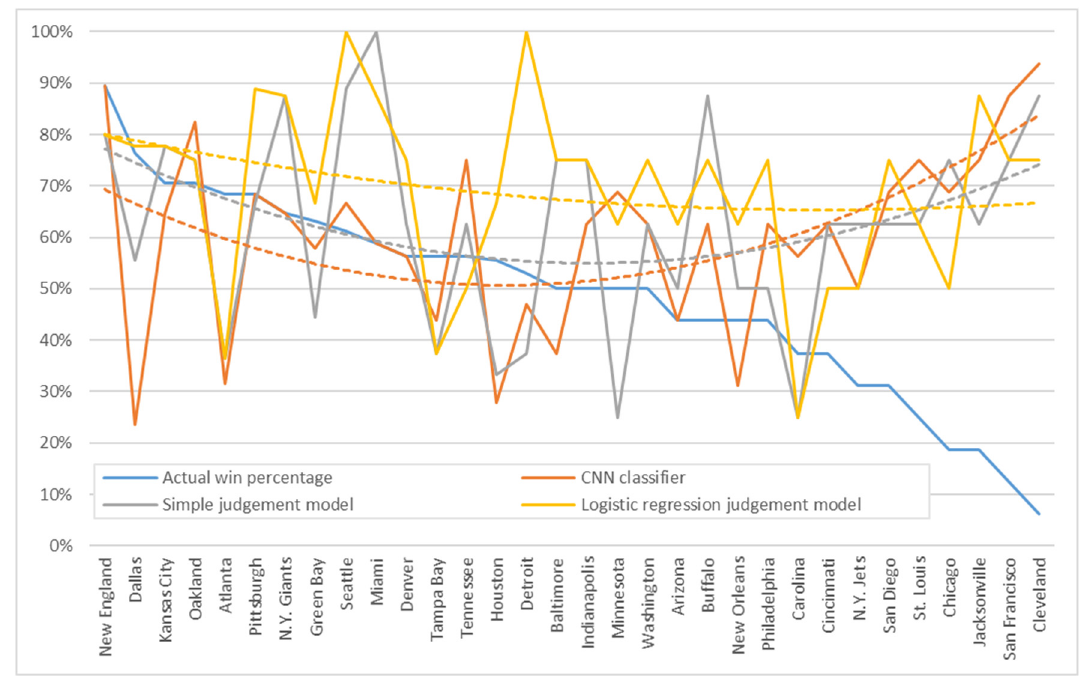
Figure 9. Accuracy comparison of the individual behavior (each team).